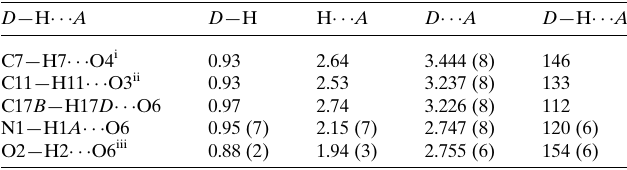
Table 1 Hydrogen-bond geometry (A˚ , (cid:2) ) for BF1.